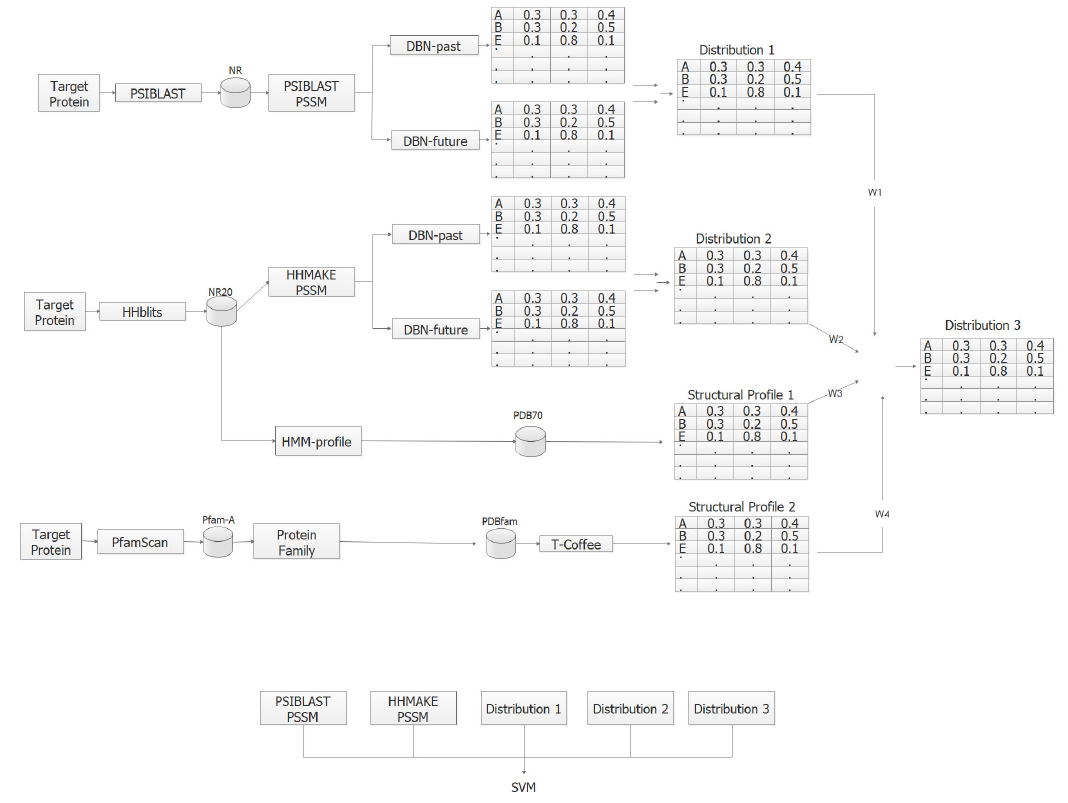
Figure 3. The steps of the DSPRED method.